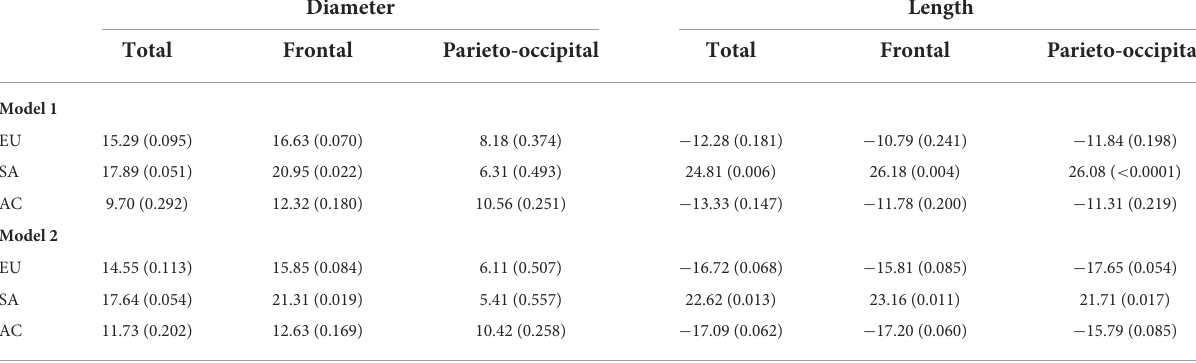
TABLE 2 Partial Spearman correlation coefficients presented as % ( p -value) between basilar artery characteristics and WMH volumes after correction for age, sex, CoW variants and height/TIV for Model 1 and further adjusting for demographic and cardiovascular confounders (Model 2). Diameter